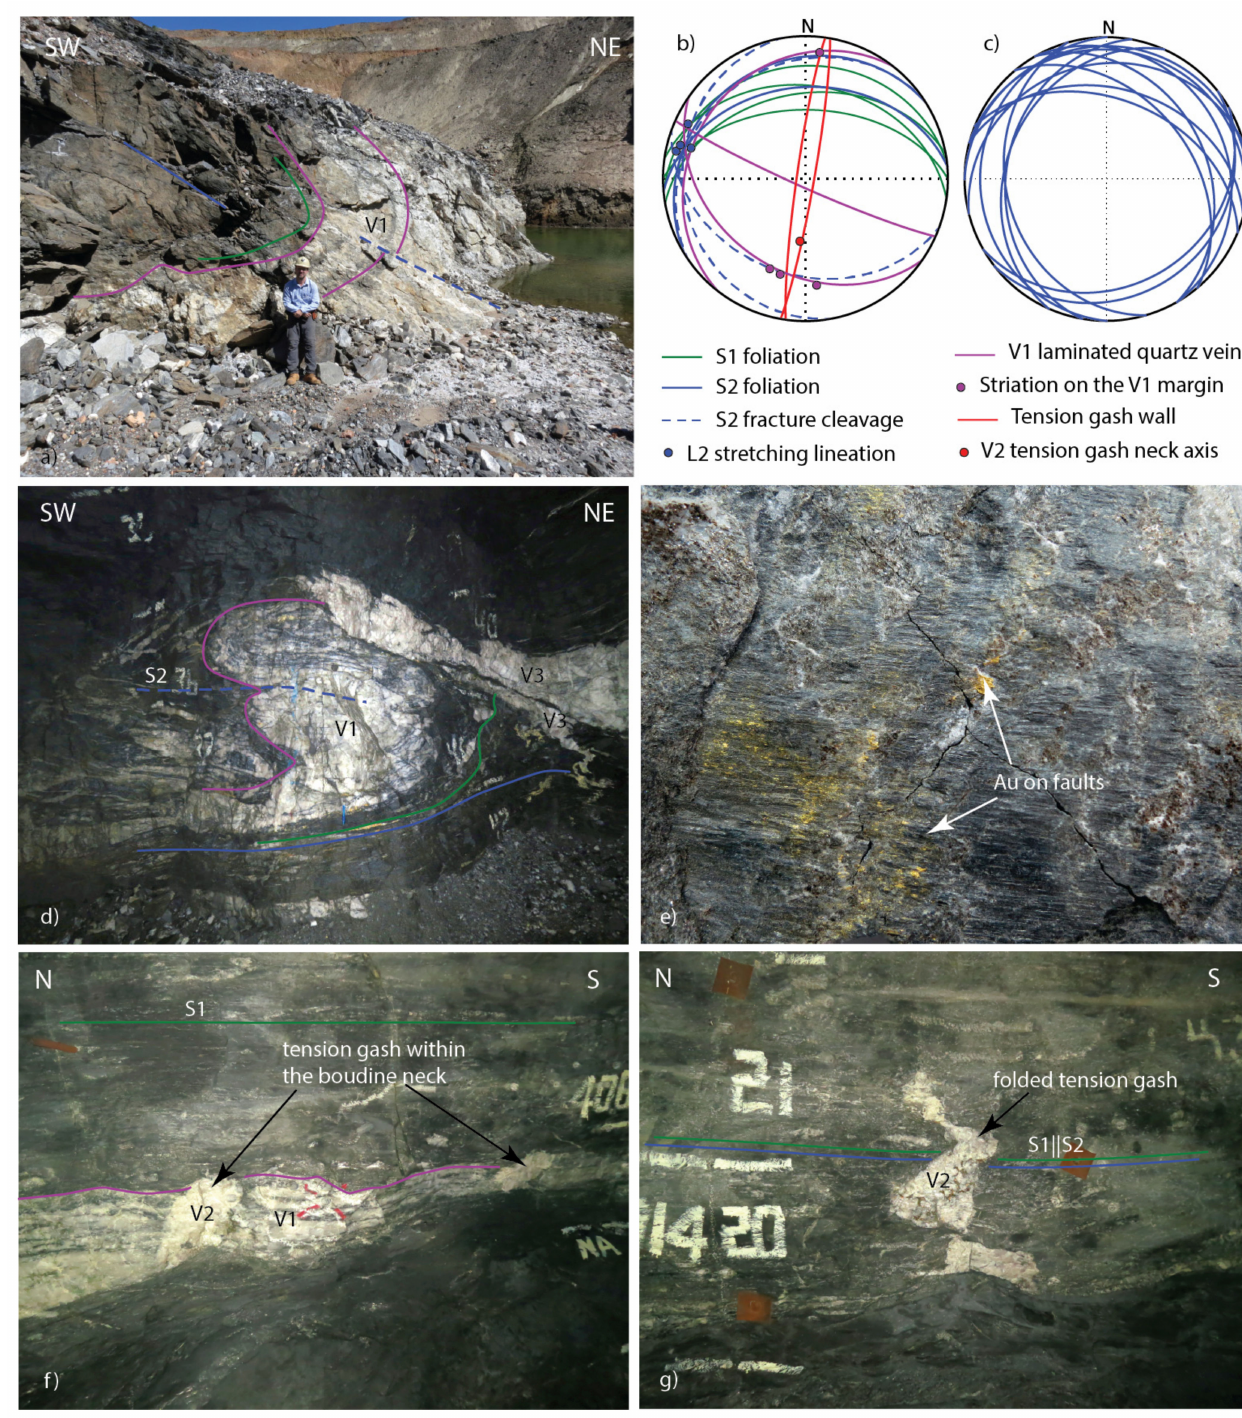
Figure 7. Structures related to the D2 deformation event. ( a ) Hinge of meters thick laminated quartz vein in the Mina III open pit; ( b ) Planar (great circles) and linear (points) structural data collected in the outcrop in A within the Mina III open pit; ( c ) S2 foliations (great circles) measured underground in the close vicinity to the folded laminated veins; ( d ) Typical structural scenario within the ore zone of the Structure III. Recumbent folding of laminated quartz veins within sulfide-bearing carbonaceous schists; ( e ) Native gold on fault surfaces of reactivated laminated quartz vein margins; ( f ) Quartz-carbonate tension gashes fill necks of boudinaged laminated quartz vein in the Pequizao orebody; ( g ) Folded quartz-carbonate-pyrrhotite tension gash within carbonaceous schist in the Pequizao